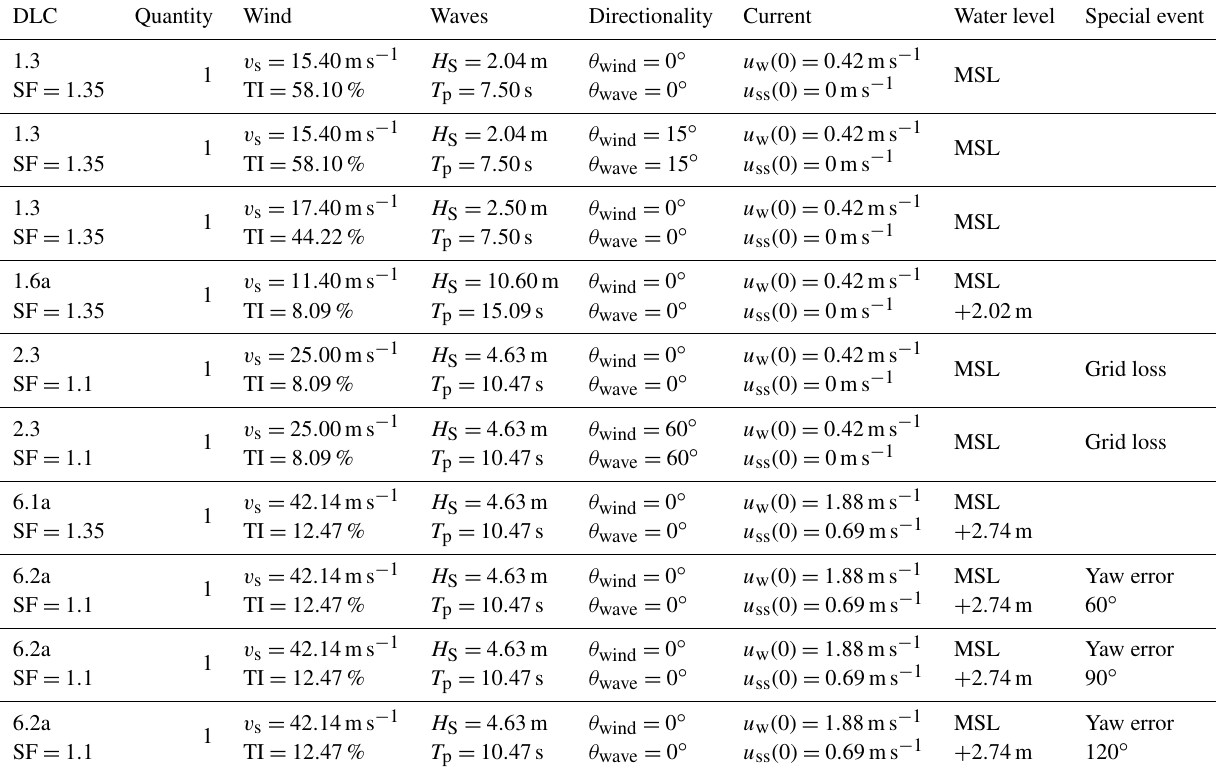
Table 3. Considered design load sets according to IEC-61400-3 (International Electrotechnical Commision, 2009) for the ultimate limit state (SF: partial safety factor, v s : mean wind speed, TI: turbulence intensity, H s : significant wave height, T p : wave peak period, θ wind : wind direction, θ wave : wave direction, u w : near-surface current velocity, u ss : subsurface current velocity, MSL: mean sea level). Yaw error is constantly set to − 8 ◦ if not stated